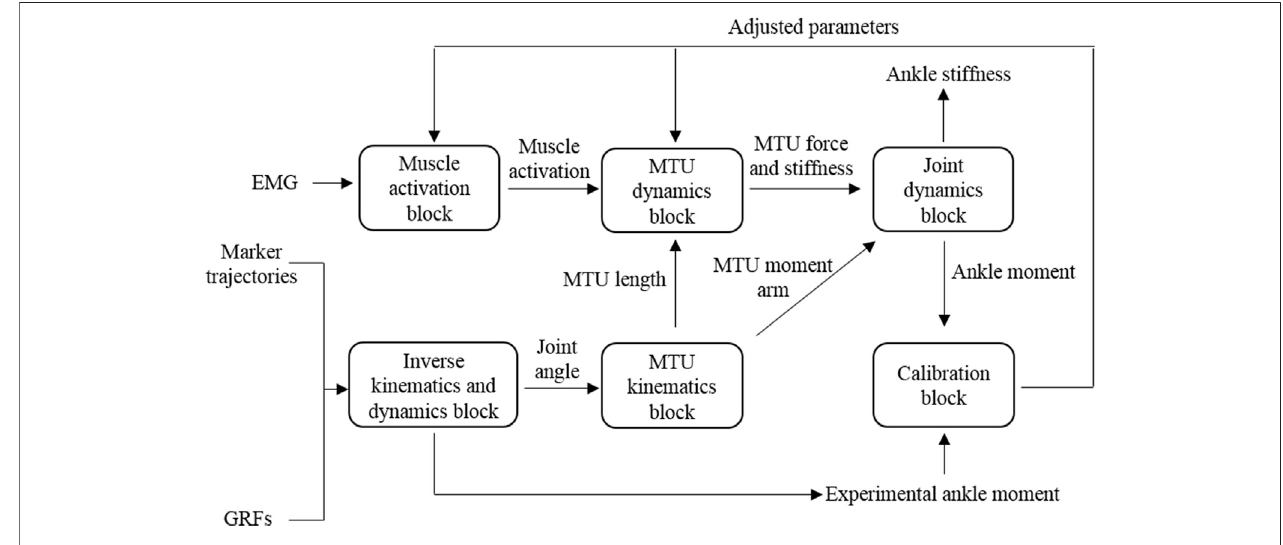
FIGURE 1 | Schematic structure of electromyography (EMG)-driven musculoskeletal